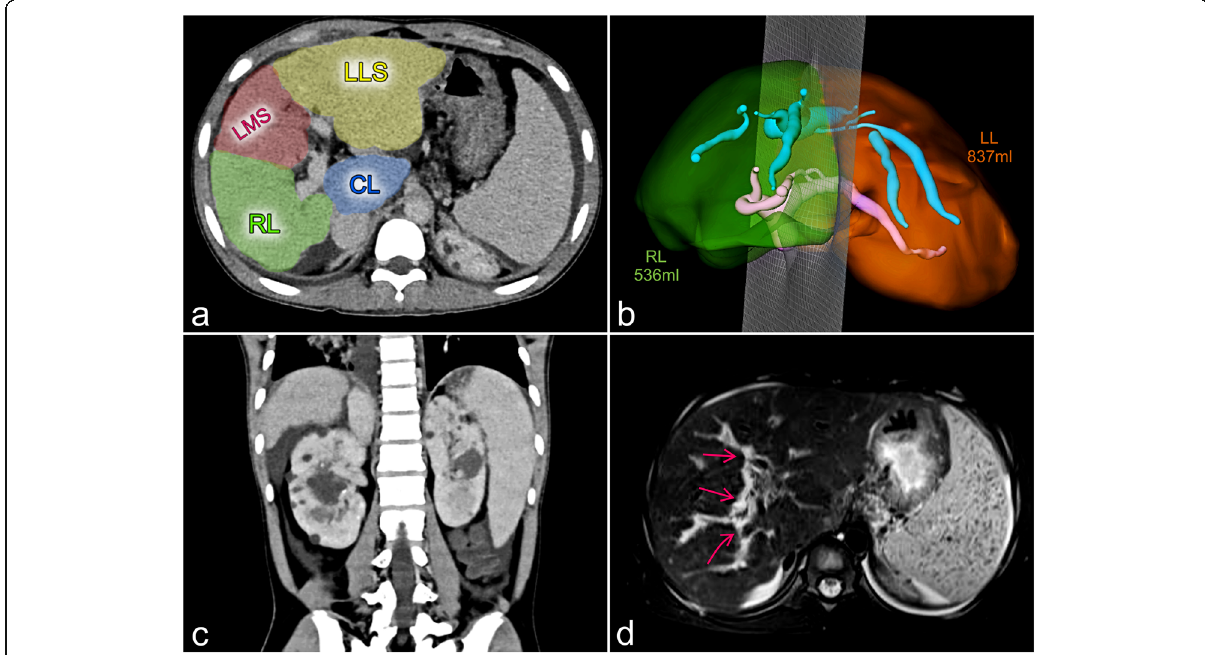
Fig. 1 a Contrast-enhanced computed tomography (CECT) portal phase (axial section at the level of portal vein bifurcation) showing hypertrophic left lateral (yellow) and medial (red) segments, hypertrophic caudate lobe (blue), and atrophic right lobe (green). LLS — left lateral segment, LMS — left medial segment, RL — right lobe, CL — caudate lobe. b Three-dimensional virtual liver segmentation showing hypertrophied left lobe (837cc) vs small right lobe (536cc). RL — right lobe, LL — left lobe. c Coronal section in CECT showing multiple cysts in bilateral kidneys. d T2-weighted magnetic resonance imaging showing high periportal signal intensities with widened portal tracts (red